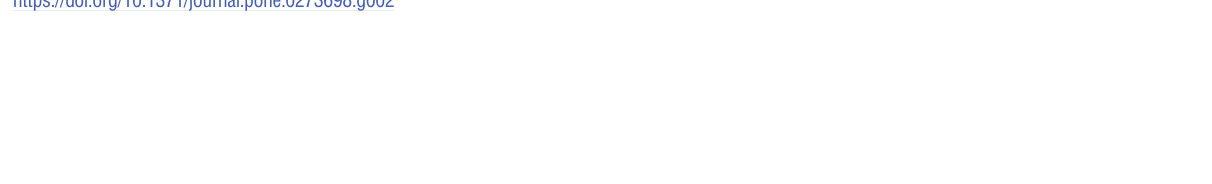
PLOS ONE | https://doi.org/10.1371/journal.pone.0273698 September 15,